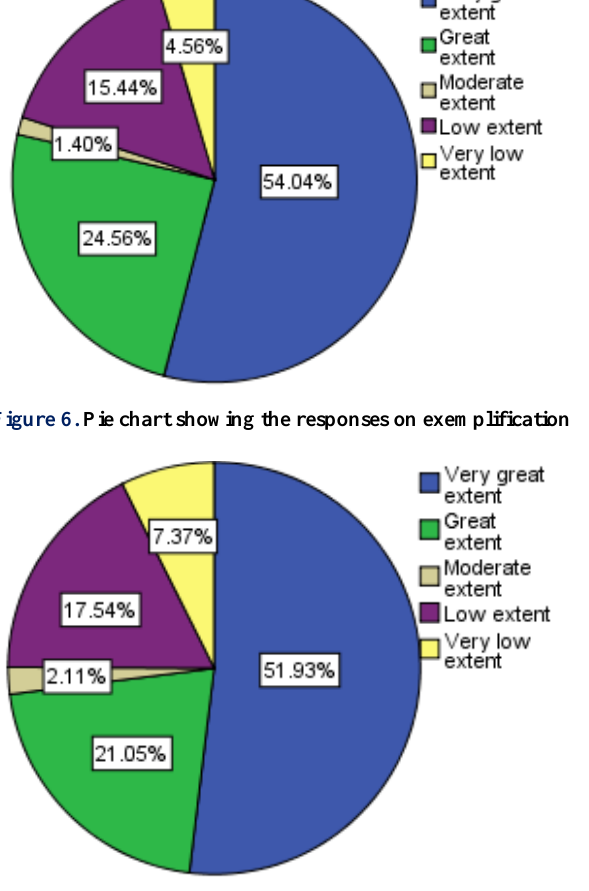
Figure 7. Pie chart showing the responses on enterprise